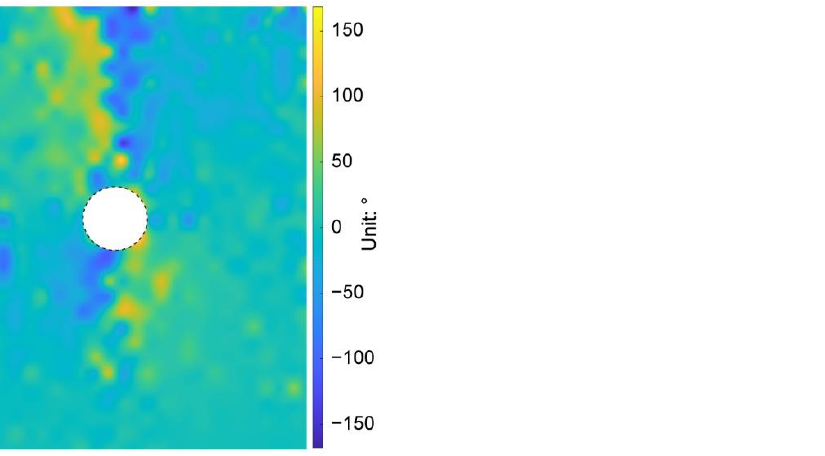
Figure 13. Directions of the principal stresses ( a ) before and ( b ) after the tunnel excavation. The red and blue segments indicate the maximum and minimum principal stresses, respectively.